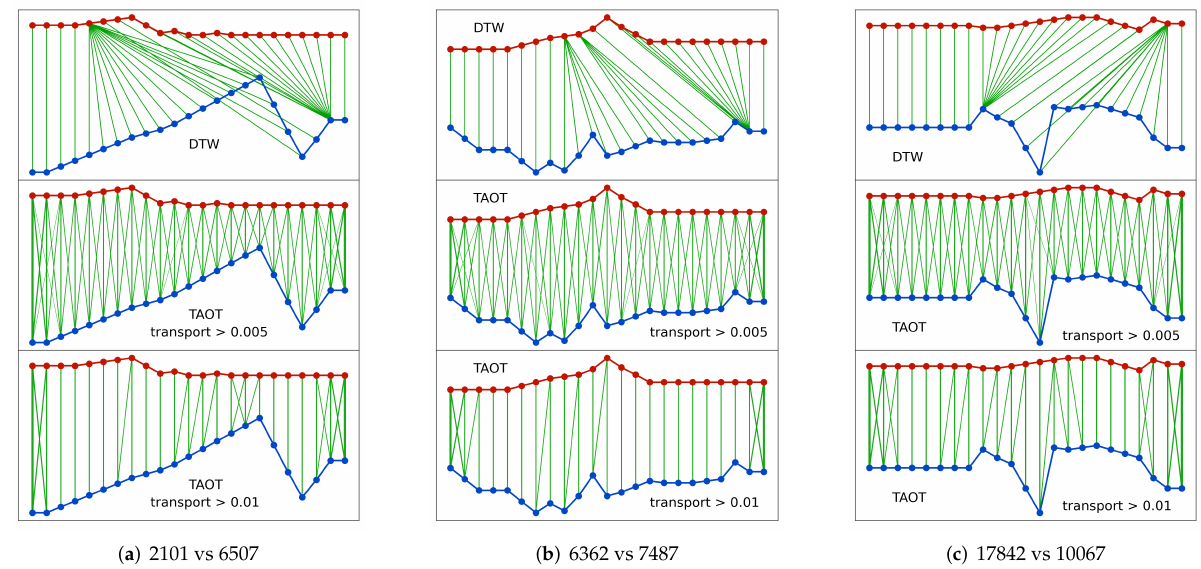
Figure 12. Alignments generated by DTW and TAOT between time series from the TiSeLaC Reunion Island dataset. The subtitles of figures show the indices of time series in the testing set. ( a ) 2101 vs. 6507; ( b ) 6362 vs. 7487; ( c ) 17842 vs.